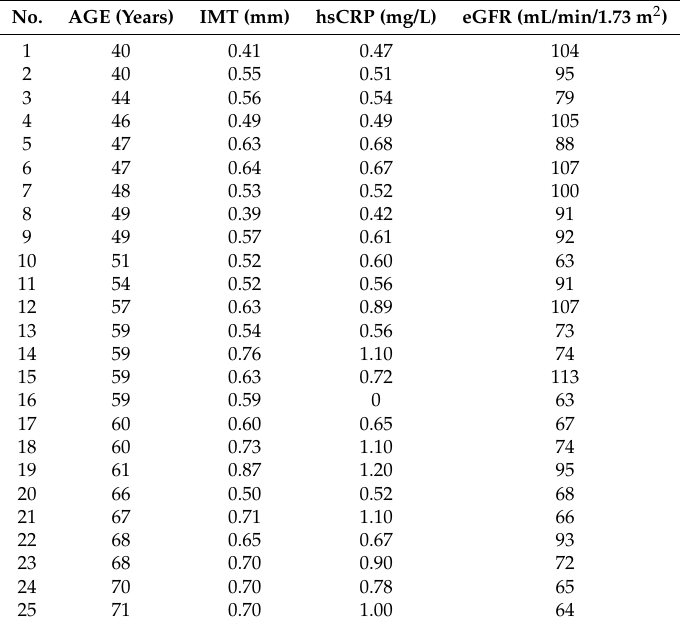
Table A2. Clinical data—healthy